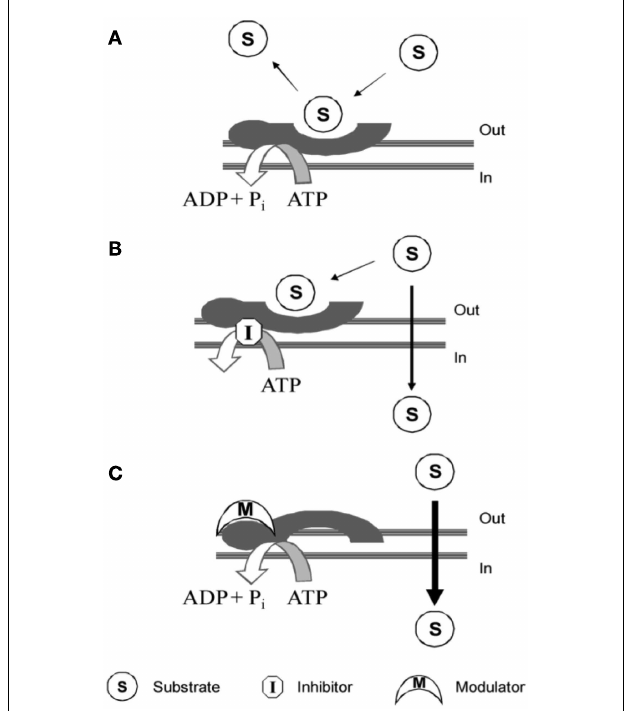
FIGURE 4 | P-gp interacting mechanism of: (A) substrate; (B) inhibitor; (C) modulator . Picture reported in Journal of Medicinal Chemistry (2010) 53:1883–97.